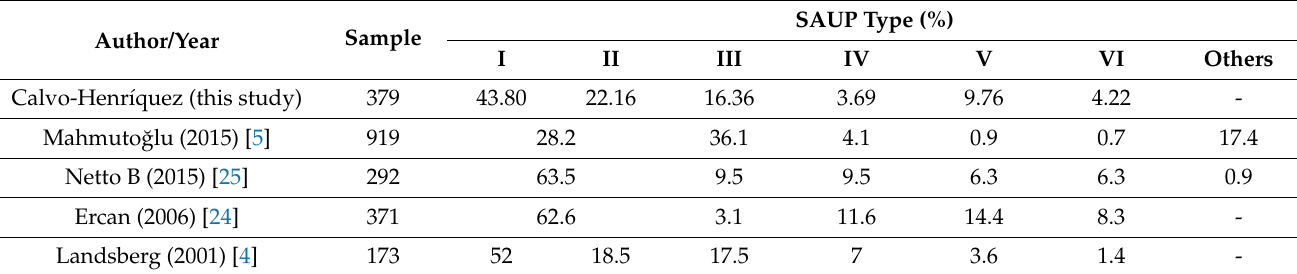
Table 2. Prevalence of SAUP